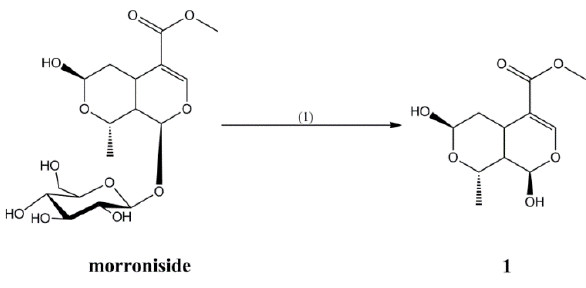
Figure 1. Synthesis of Compound 1 . (1) 20% HCl, 50 °C, 1 h.